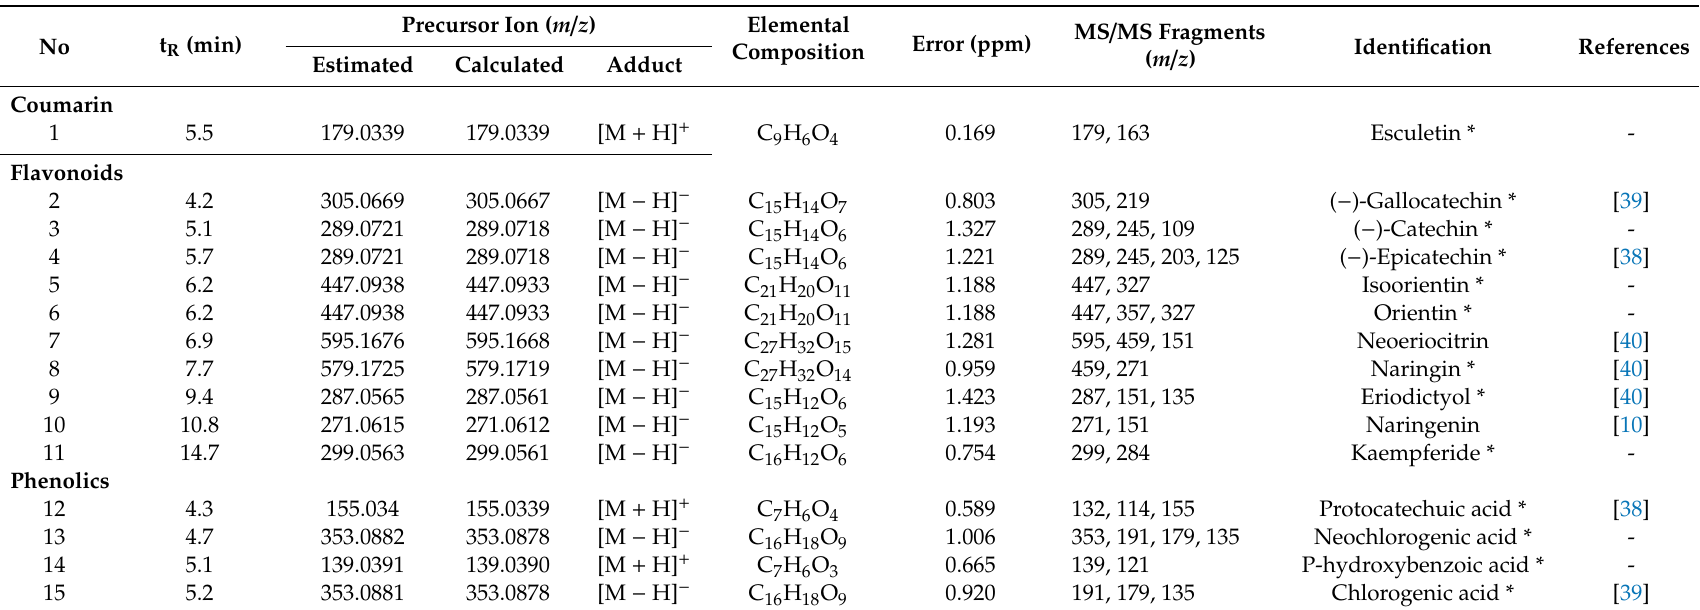
Table 1. Profile of chemical constituents of WDR by UHPLC–MS /